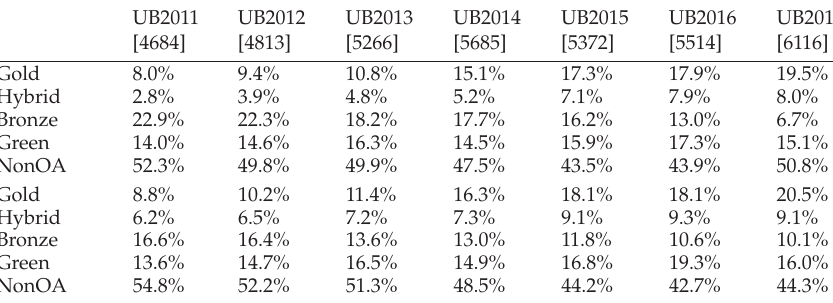
The top values are the ones obtained in June 2018 and the bottom values obtained in March 2019. In brackets the total number of Table 3: Percentages of open access from the UPC data 2011–2017.